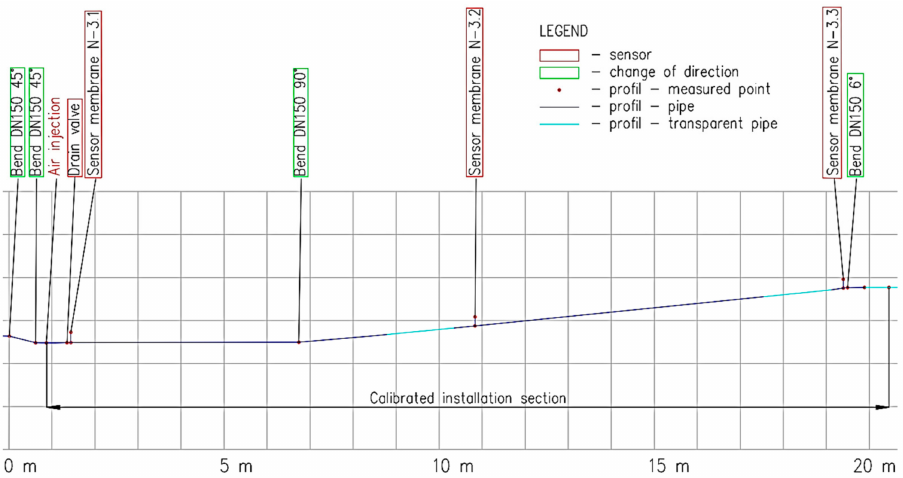
Figure 2. Profile of the analyzed installation section with a siphon 19.83 m in length; the liquid flow is from left to right.